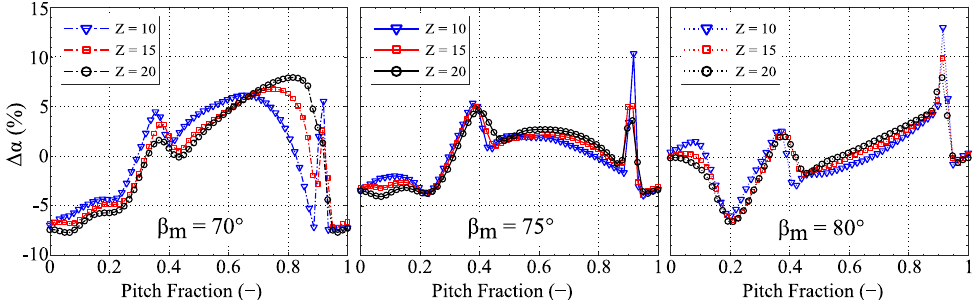
Figure 10. Mid-span pitch-wise flow angle (abs. frame of reference) distribution at rotor inlet radius expressed as a percent deviation with respect to mean value, grouped by outlet metal angle.